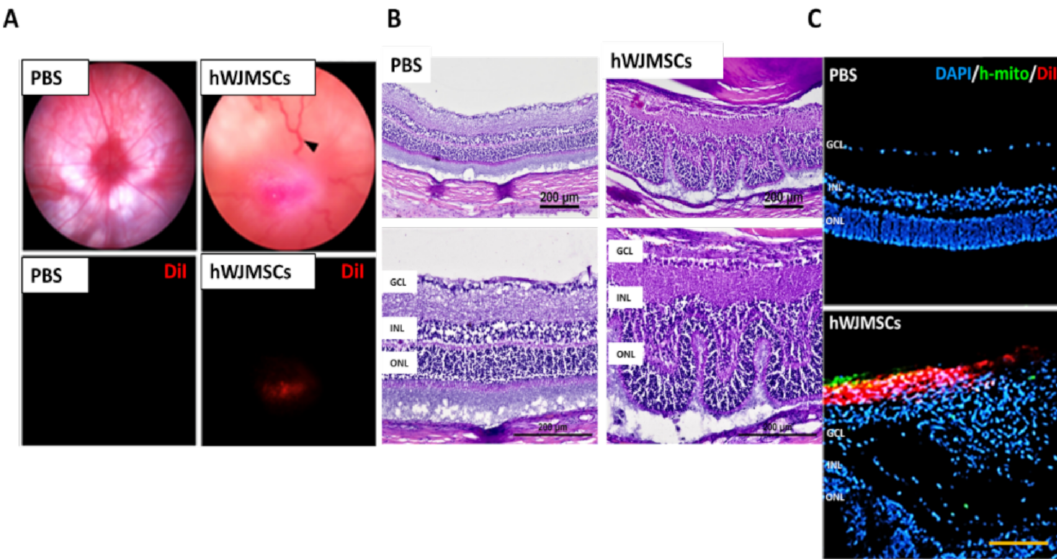
Figure 1. The intravitreal delivery of human Wharton’s jelly mesenchymal stem cells (hWJMSCs) in rat retina four weeks after transplantation. ( A ) Ocular color fundus images in the PBS-treated group and the hWJMSC-treated group. The black arrowhead indicates retinal venous congestion. Red fluorescence shows the DiI-labeled hWJMSCs in the vitreous cavity. Digital magnification (800%) ( B ) Hematoxylin and eosin staining of retinal sections. The hWJMSC transplantation resulted in retinal structural deformity. GCL: ganglion cell layer; INL: inner nuclear layer; ONL: outer nuclear layer. Scale bar 200 µ m. ( C ) Immunohistochemistry of human mitochondria staining and DiI-labeled cells in the PBS-treated group and the hWJMSC-treated group. Scale bar 100 µ m. DAPI, 4, 6-diamidino-2-phenylindole; h-mito, human-mitochondria; DiI: Int. J. Mol. Sci. 2021 , 22 , 2117 1,1’-Dioctadecyl-3,3,3’,3’-Tetramethylindocarbocyanine Perchlorate.